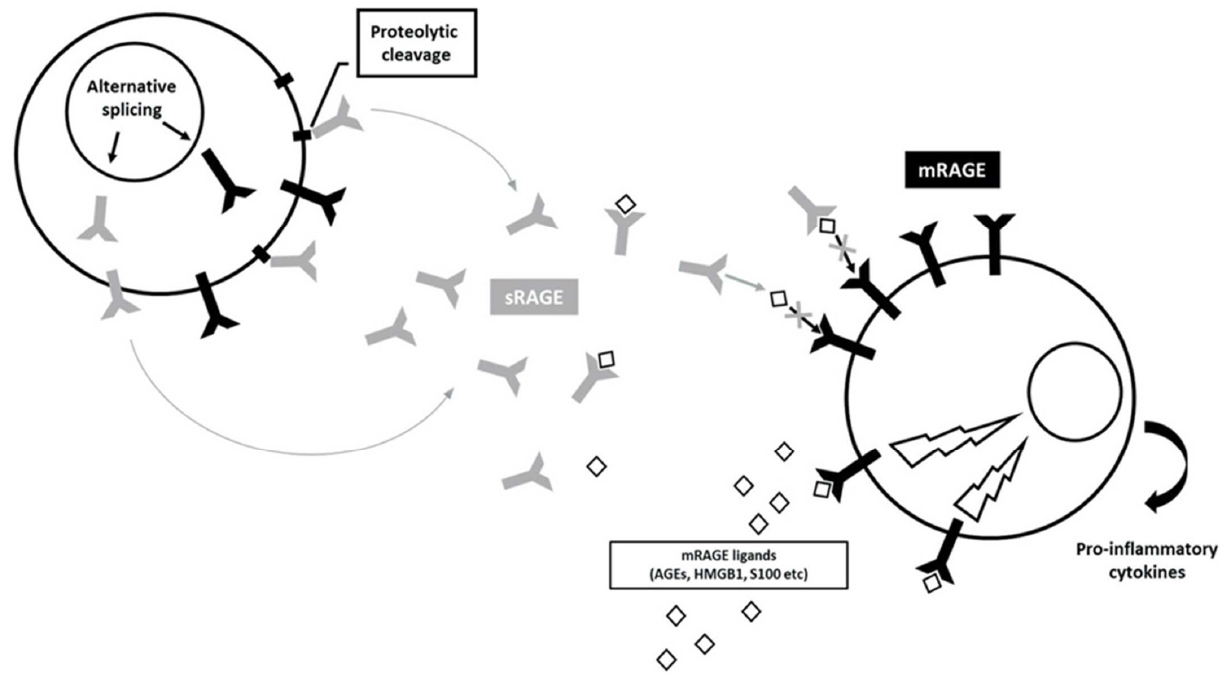
Figure 1. sRAGE synthesis and action. sRAGE is produced by alternative splicing events or by proteolytic cleavage. sRAGE includes the extracellular domain of mRAGE. On release, it acts as a decoy, trapping the mRAGE receptor ligands and blocking signal transduction.